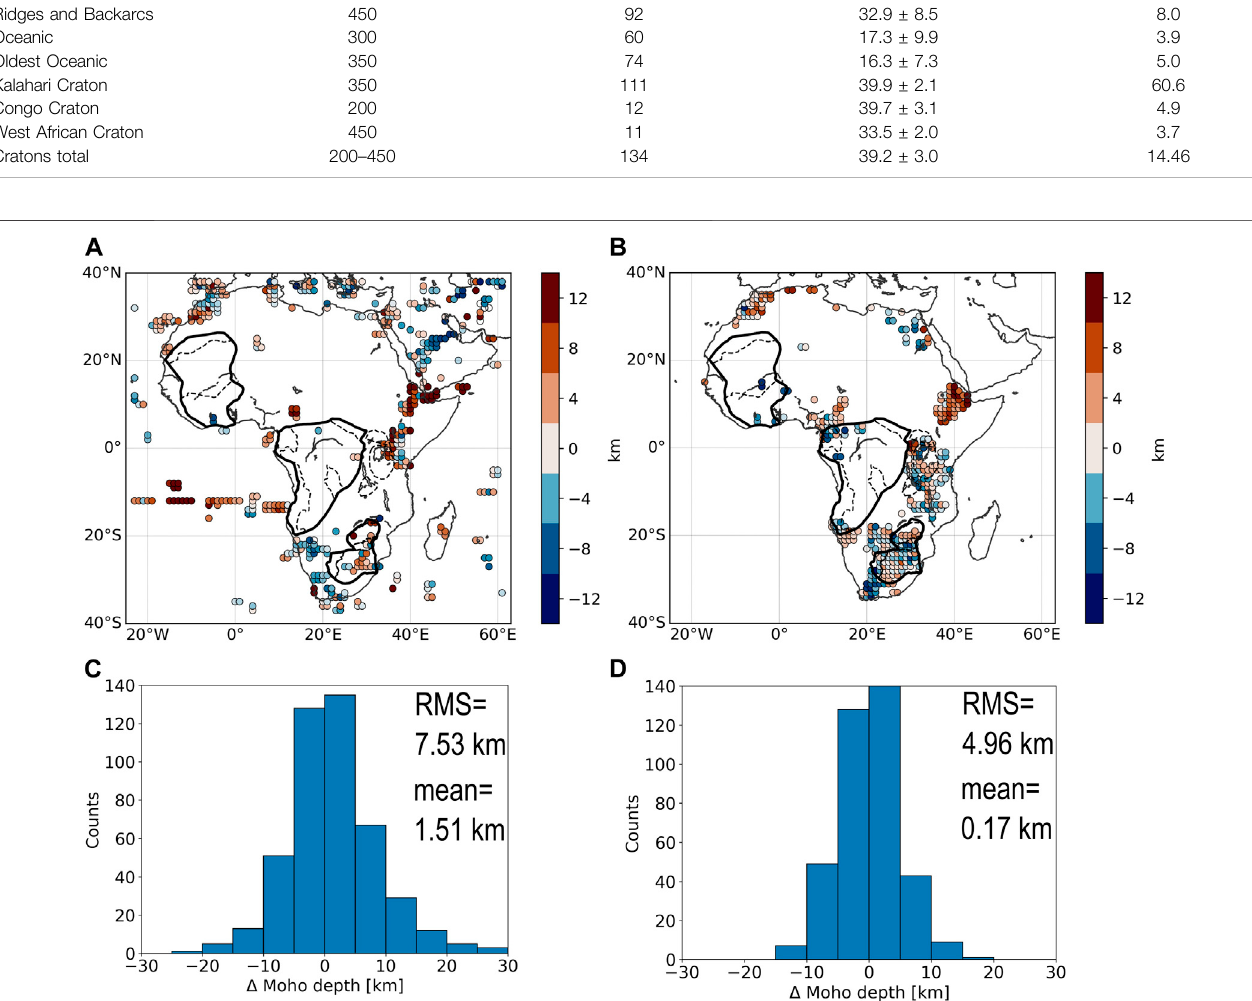
FIGURE 7 | Fit of the estimated Moho depth to the seismic constraints. Red colours indicate a deeper estimated Moho depth, while blue colours indicate a shallower Moho depth compared to the seismic constraints. (A) Estimated Moho depth minus AS constraints, (B) Estimated Moho depth minus RF constraints, (C) Histogram of differences for AS constraints, (D) Histogram of differences for RF constraints.